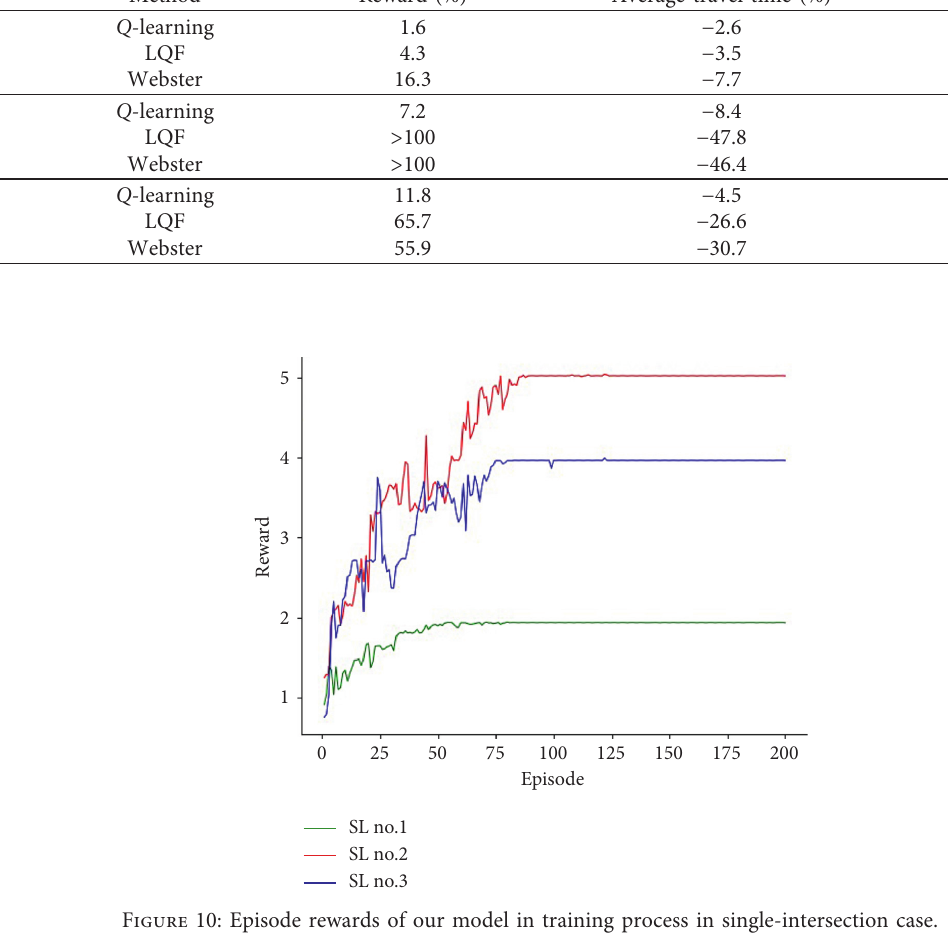
Table 4: Improvements in measures of our model relative to those of other methods for single-intersection case. SL no.